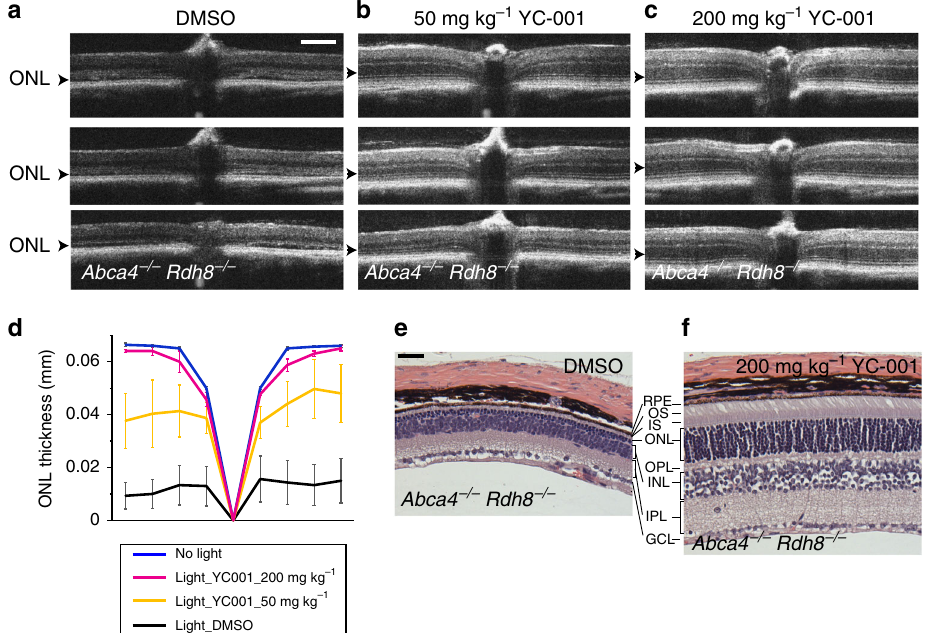
Fig. 6 YC-001 protects Abca4 − / − Rdh8 − / − mouse retinas from light damage. Owing to the loss of both ABCA4 and RDH8, all- trans -retinal cannot be ef fi ciently cleared from the ROS of Abca4 − / − Rdh8 − / − mice. Thus, their retinas undergo degeneration upon exposure to intense light. Here, Abca4 − / − Rdh8 − / − mice were treated with either DMSO or YC-001 i.p. 30 min before exposure to 10,000 lux light for 30 min. SD-OCT images were taken seven days after light exposure ( a – d ). Mice then were euthanized and their eyes were used for histological examination ( e , f ). a SD-OCT images from mice treated with 50 µ L DMSO. Arrowheads indicate signi fi cantly degenerated ONL. Scale bar, 200 μ m. b , c SD-OCT images from mice treated with 50 or 200 mg kg − 1 bw of YC-001, respectively. d Plots of ONL thickness from SD-OCT images in ( a – c ). Lines represent averaged ONL thicknesses from three mice and error bars are the s.d.s. n = 3. e HE staining of Abca4 − / − Rdh8 − / − mouse retina seven days after pre-incubation in DMSO and exposure to 10,000 lux light. Scale bar, 100 μ m. f HE staining of Abca4 − / − Rdh8 − / − mouse retina seven days after pretreatment with 200 mg kg − 1 bw YC-001 and exposure to 10,000 lux light. RPE retinal pigmented epithelium, OS outer segment, IS inner segment, ONL outer nuclear layer, OPL outer plexiform layer, INL inner nuclear layer, IPL inner plexiform layer, GCL ganglion cell layer. This experiment was repeated